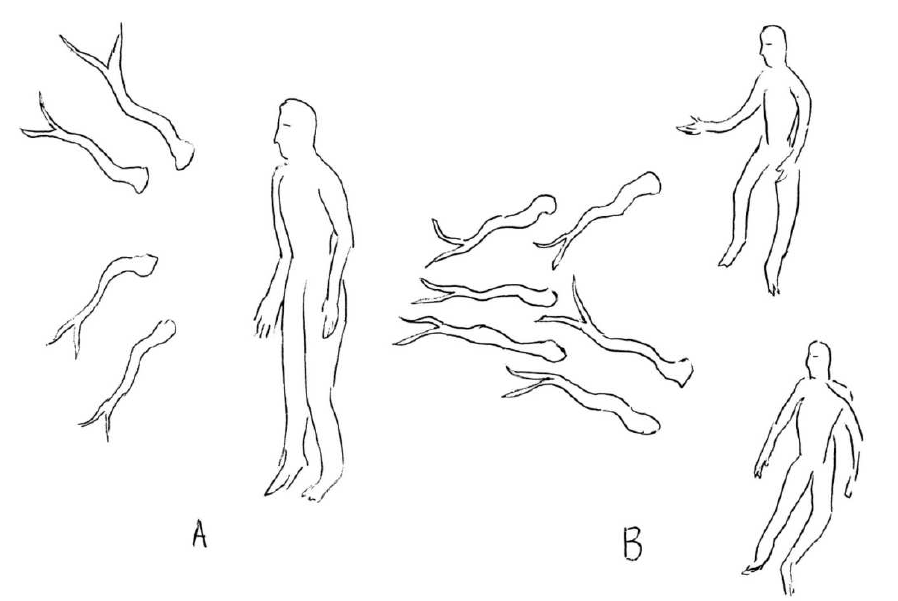
Figure 1. The stimulation of the following operations in cercariae motions: (A) the fusion of cercariae collectives, (B) the multiplication of cercariae collective, where the human beings are